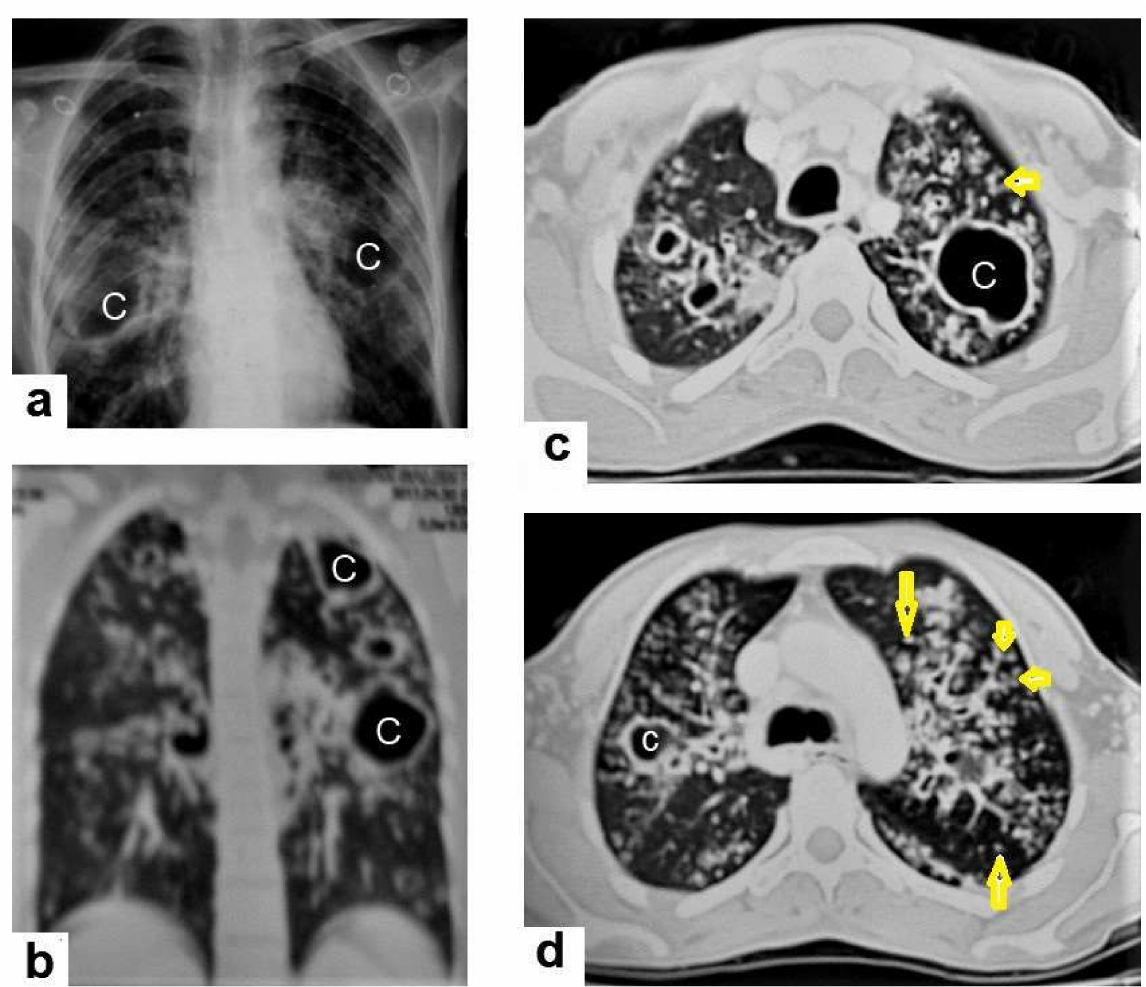
Figure 4. Reactivated TB in a 34-year-old women. ( a ) Chest radiograph shows extensive reticular shadowing and multiple cavitary lesions in both lungs. ( b ) Coronal reconstruction CT shows multiple cavitary lesions ( c ) in both lungs, the large two in the posterior segment of the upper lobe, and in the apical segment of the lower lobe of the left lung. ( c , d ) Axial CT images of the lung show multiple cavitary lesion, the largest in the posterior segment of the left upper lobe, with multiple centrilobular (long arrows) and tree-in-bud (short arrows)